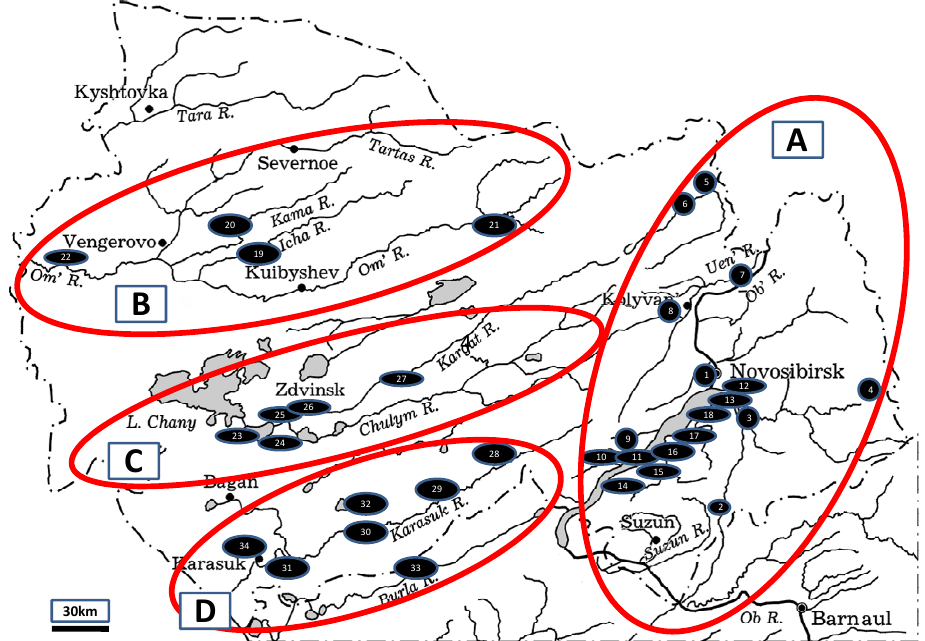
Figure 2. Sampling sites of examined bithyniid snails in four major basins in the Novosibirsk region.